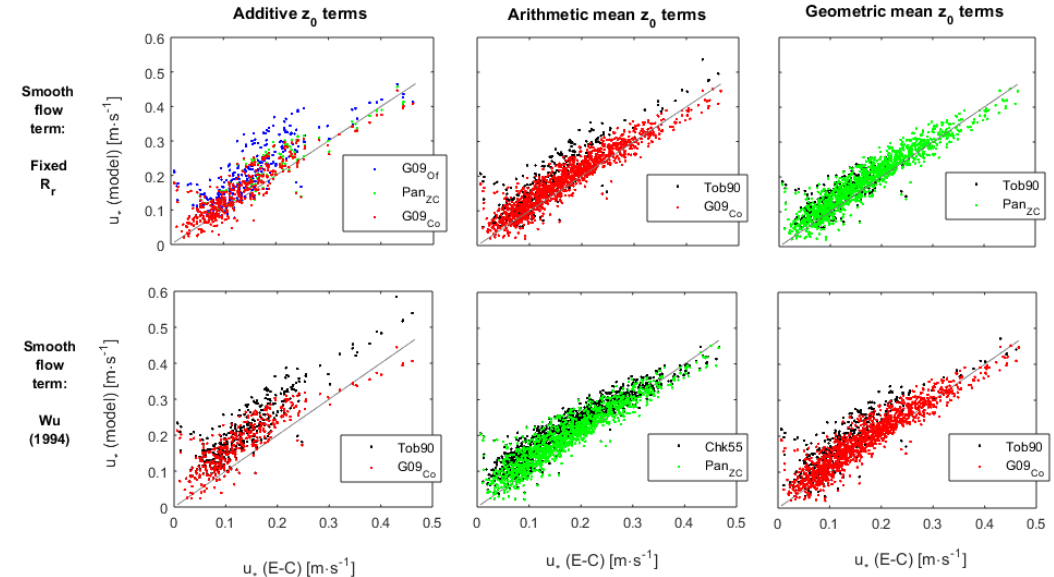
Figure 5. Definite estimation of u * iterating for convergence together with roughness length (z 0 ). Colored marks represent the roughness length under rough air-flow estimated following, Charnock [118] [Chk55, Equation (7)], Gao et al. [111] formulations for the coastal ocean [G09 Co , Equation (9a)] or off-shore [G09 Of , Equation (9b)], Pan et al. [123] [Pan ZC , Equation (12b)] or Toba et al. [97] [Tob90, Equations (7) and (8]). Roughness length under smooth air-flow was estimated following Wu [35,62] [Equation (14)] or formulations relying on a fixed R r . Smooth and rough air-flow terms under transient air-flow regimes were added, arithmetically averaged or geometrically averaged.